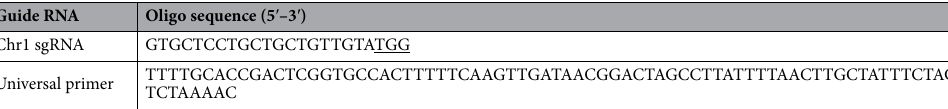
Table 1. The sequences of small guide RNA (sgRNA) and the universal (common) primer used to target chromosome 1 (Chr1) of channel catfish ( Ictalurus punctatus ). Underlined sequences represent the protospacer adjacent motif